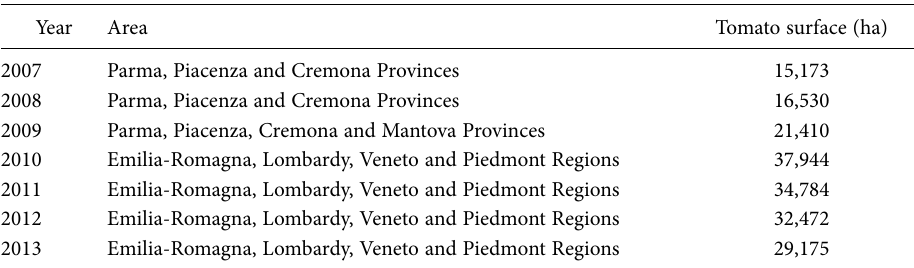
Table 1. Industrial tomato cultivation area of members of the Distretto del pomodoro da industria – Nord